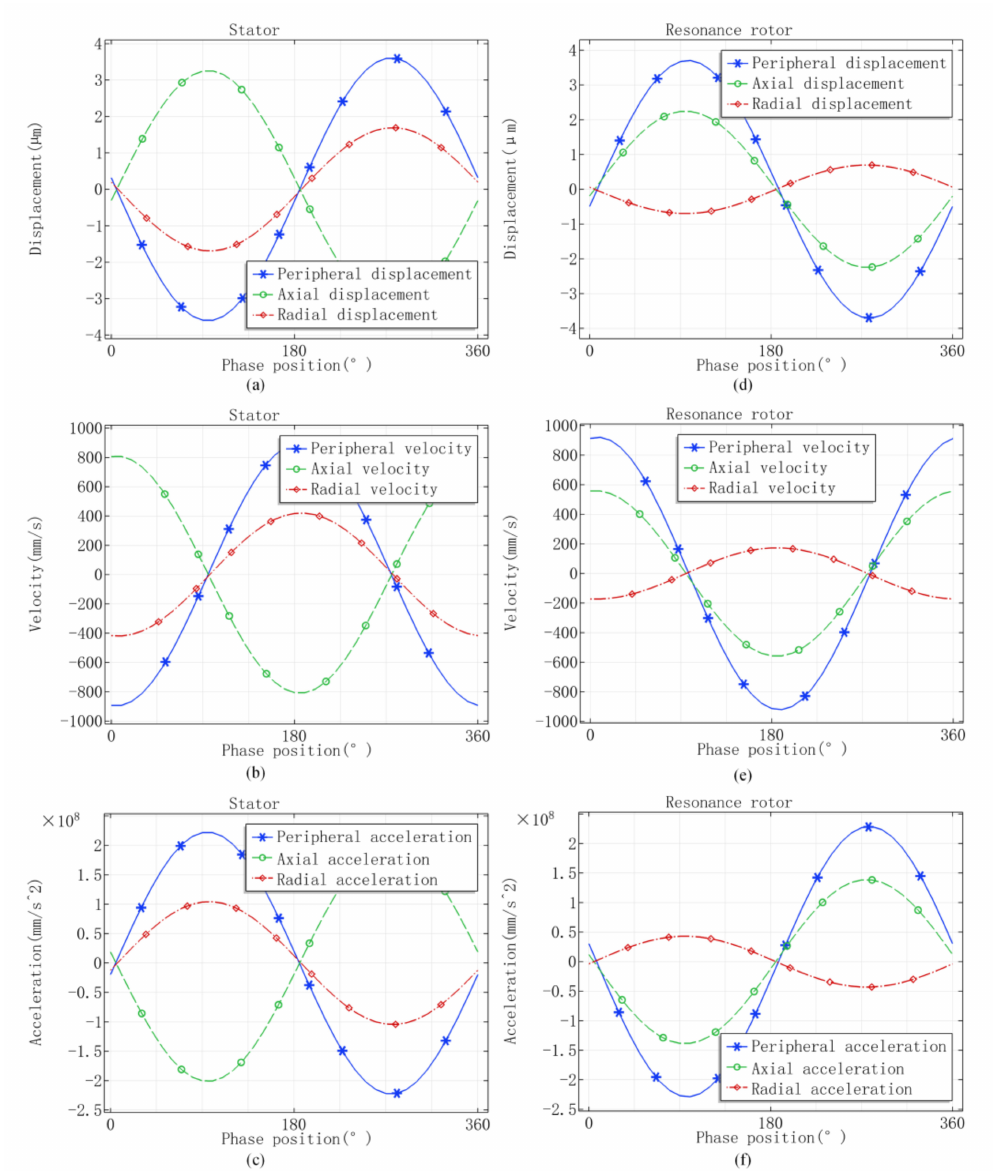
Figure 4. Modal response of stator and resonance rotor within one oscillatory period. ( a ) Periodical displacement response of stator. ( b ) Periodical velocity response of stator. ( c ) Periodical acceleration response of stator. ( d ) Periodical displacement response of resonance rotor. ( e ) Periodical velocity response of resonance rotor. ( f ) Periodical acceleration response of resonance